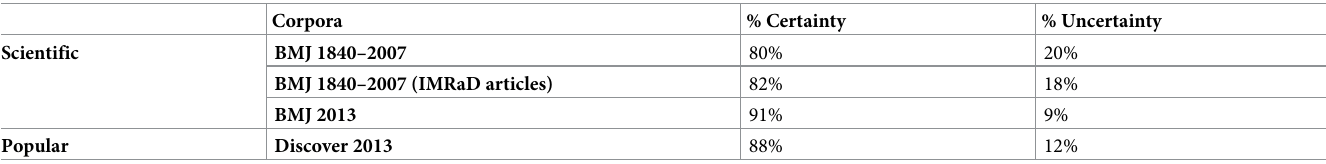
Table 21. Percentages of certainty and uncertainty in scientific and popular